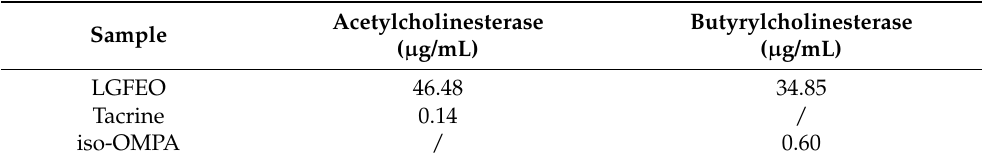
Table 5. Cholinesterase inhibitory activity of the LGFEO by IC 50